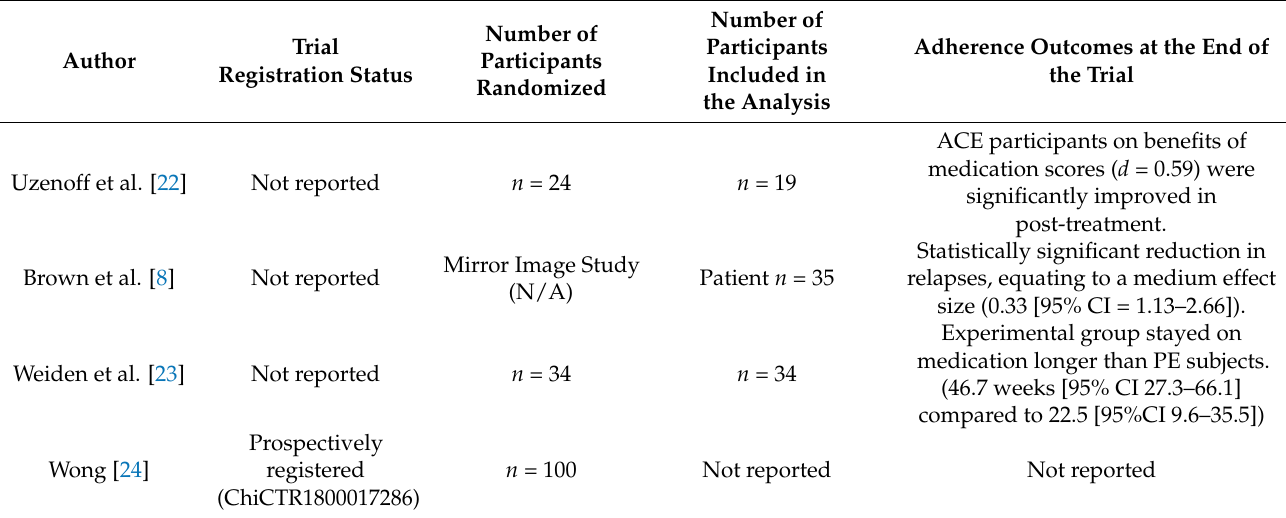
Table 2. Extracted data from included